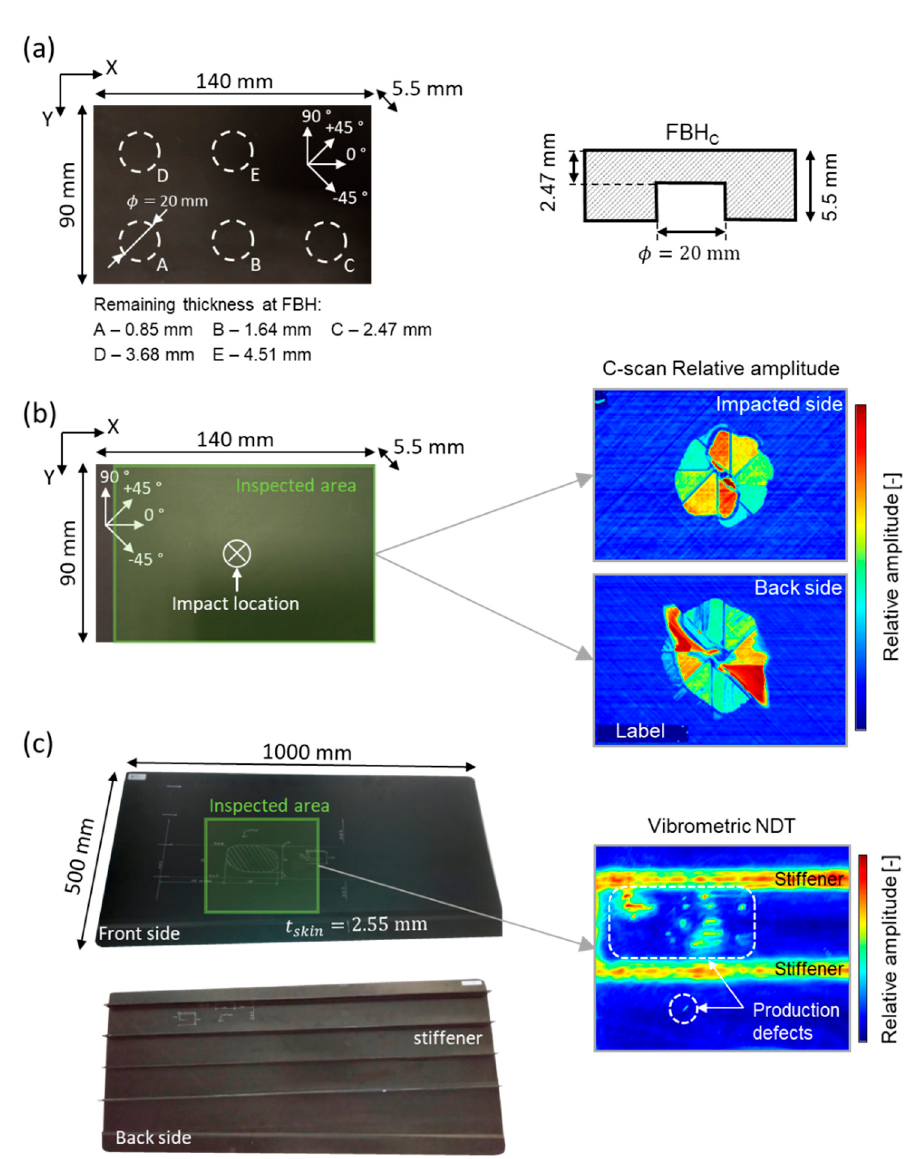
Figure 1. Photographs of ( a ) carbon fiber reinforced polymer (CFRP) FBH coupon (and schematic illustration of flat bottom hole FBH C ); ( b ) CFRP BVID coupon, and the corresponding ultrasonic C-scan results; and ( c ) CFRP PROD panel with backside stiffeners, and the damage map obtained by a broadband vibrometric NDT technique [33].